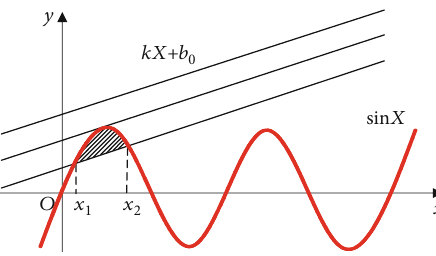
Figure 2: Curve relation of critical state equation. Figure 3: Plastic region.